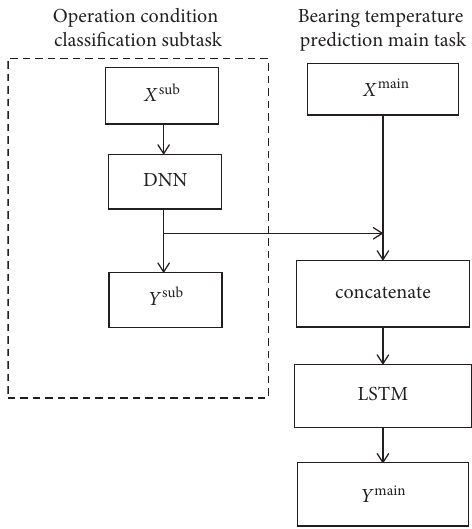
Figure 5: Multitask learning